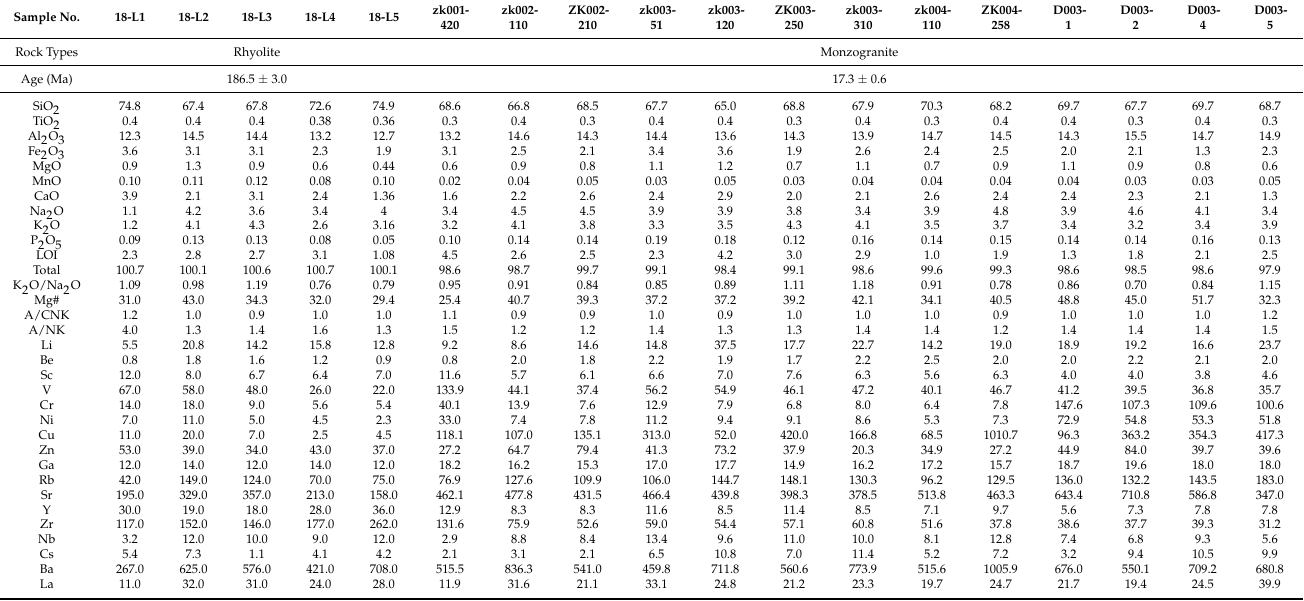
Table 1. Major (wt.%) and trace element (ppm) concentrations of monzogranite and rhyolite samples from the Demingding